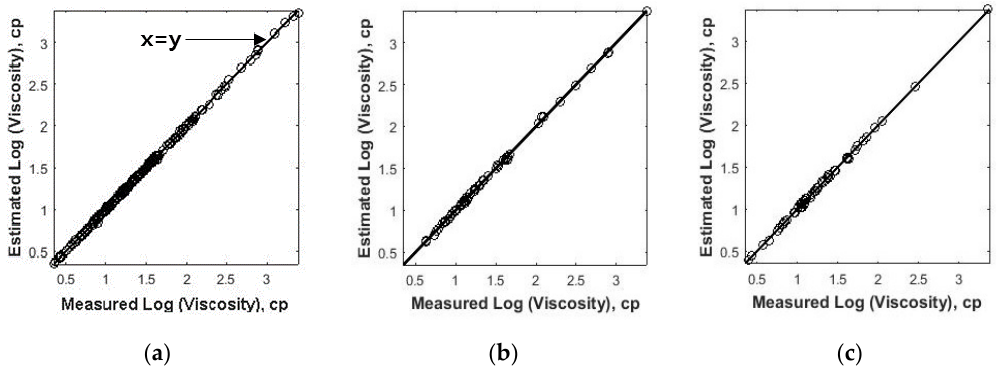
Figure 5. Comparison of the measured and estimated data for Flopaam TM 3330S, cp is centi-poise. ( a ) Training. ( b ) Validation. ( c ) Test.